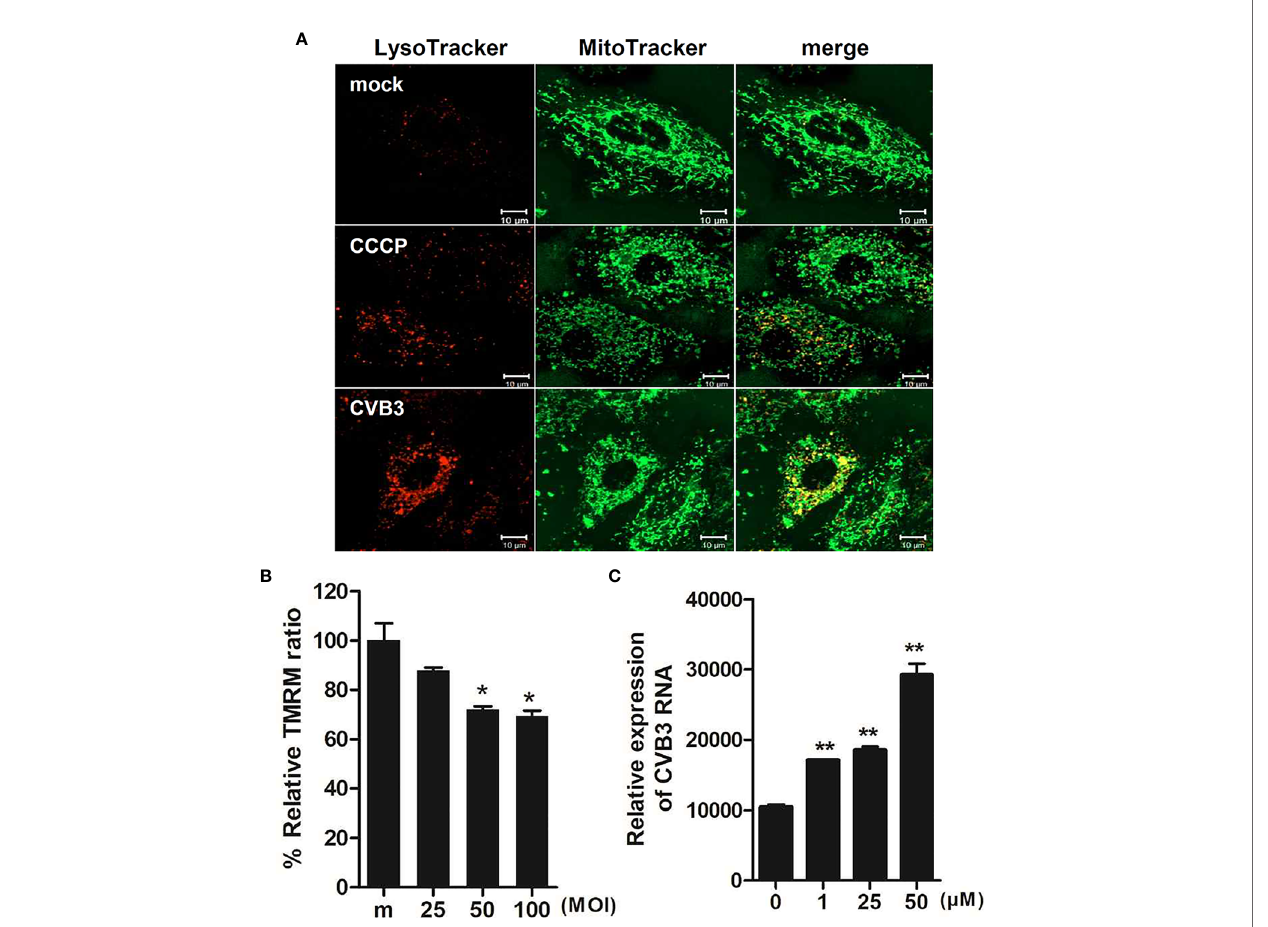
FIGURE 8 | Effect of CCCP-mediated mitophagy following CVB3 infection in H9C2 cardiomyocytes (A) H9C2 cells were treated with 25 m M CCCP for 2 hours or infected with mock or CVB3 for 24 h (MOI =50). The cells were subsequently stained with MitoTracker Green and LysoTracker Red. Scale bar=10 m m. (B) H9C2 cells were infected with CVB3 at different MOIs for 24 h. Relative tetramethylrhodamine methyl ester (TMRM) intensity in each group of live cells was measured using a VarioSkan LUX multiplate reader (mean ± SD; n = 2). *p < 0.05, vs . mock-infected cells (C) H9C2 cells were treated with CCCP at various concentrations and infected with CVB3 at an MOI of 50 for 24 h. CVB3 RNA copy number was quantitated, normalized, and analyzed by quantitative realtime PCR (mean ± SD; n = 2). Statistical analysis: *p < 0.05; **p < 0.01, vs . DMSO-treated